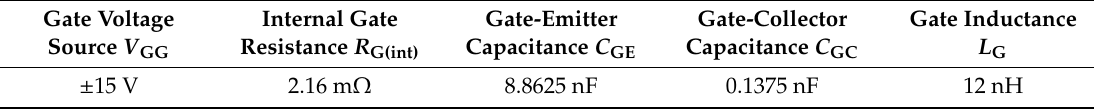
Figure 3. The physical diagram of the IGBT module and the internal equivalent circuit diagram of a single chip: ( a ) physical diagram; ( b ) equivalent circuit diagram. Table 1. Basic parameters of IGBT